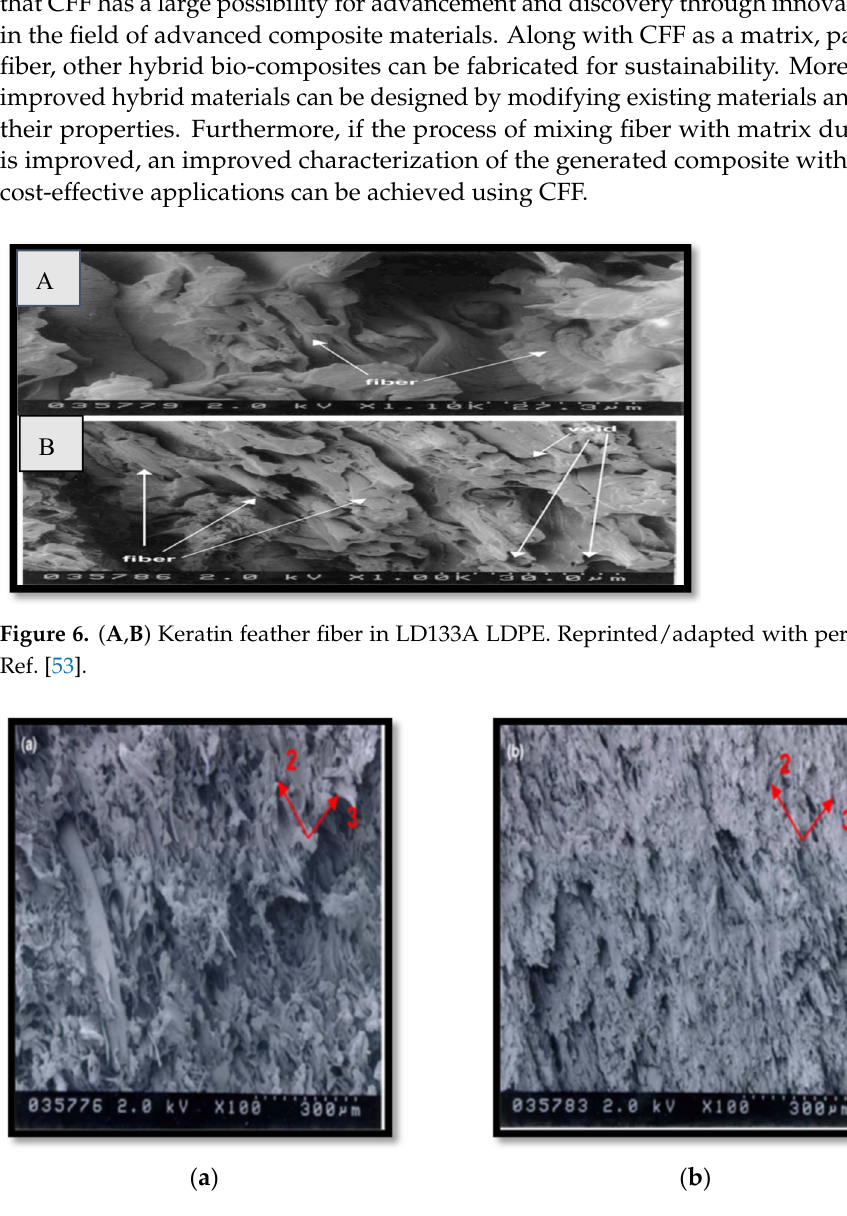
Figure 7. ( a,b ) SEM images of keratin Fiber. Reprinted/adapted with permission from Ref. [53].